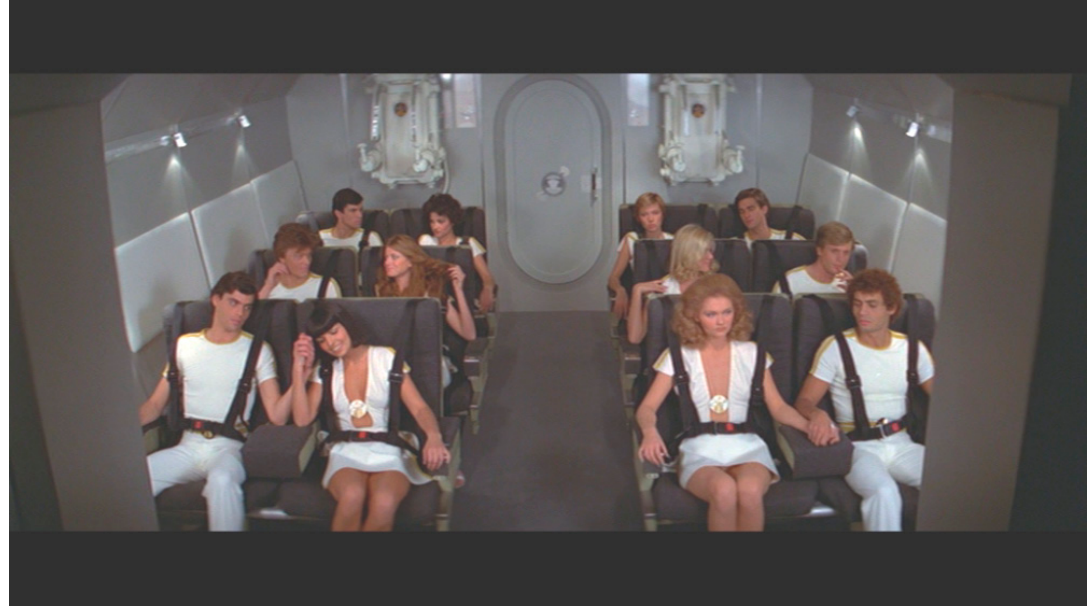
Figure 3. The future master race boards Drax’s ark ( Moonraker ).